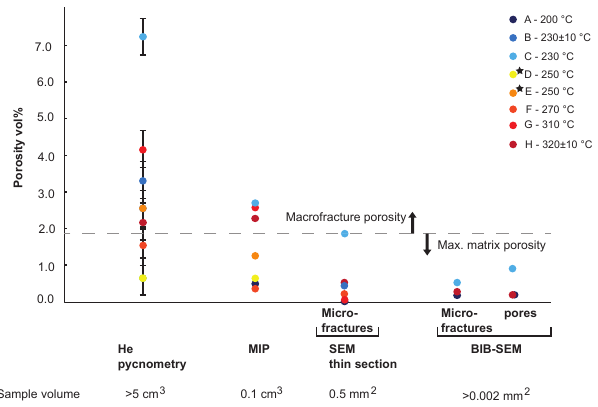
Figure 11. Porosity measurements obtained by five different meth- ods with indicated sample volumes. Stars show sub-surface sam- ples. Errors of MIP data and image analysis fall within the data markers itself. Dashed line is threshold between macro-fracture porosity (above) and matrix porosity